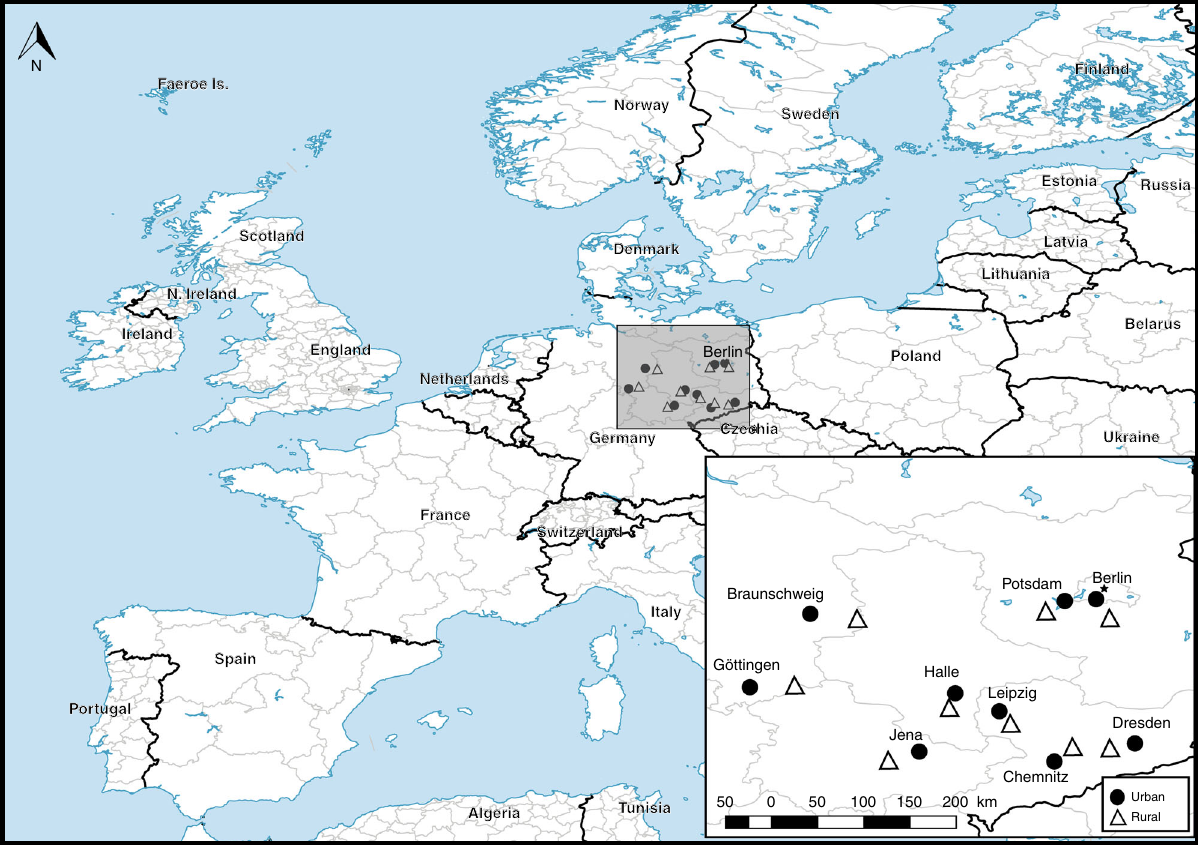
Fig. 1 Location of the 18 study sites within Germany. Cities are labelled; black circles correspond to urban sites and white triangles correspond to rural sites. This map was created with Natural Earth, free vector and raster map data @ naturalearthdata.com using QGIS Desktop. This map is licenced